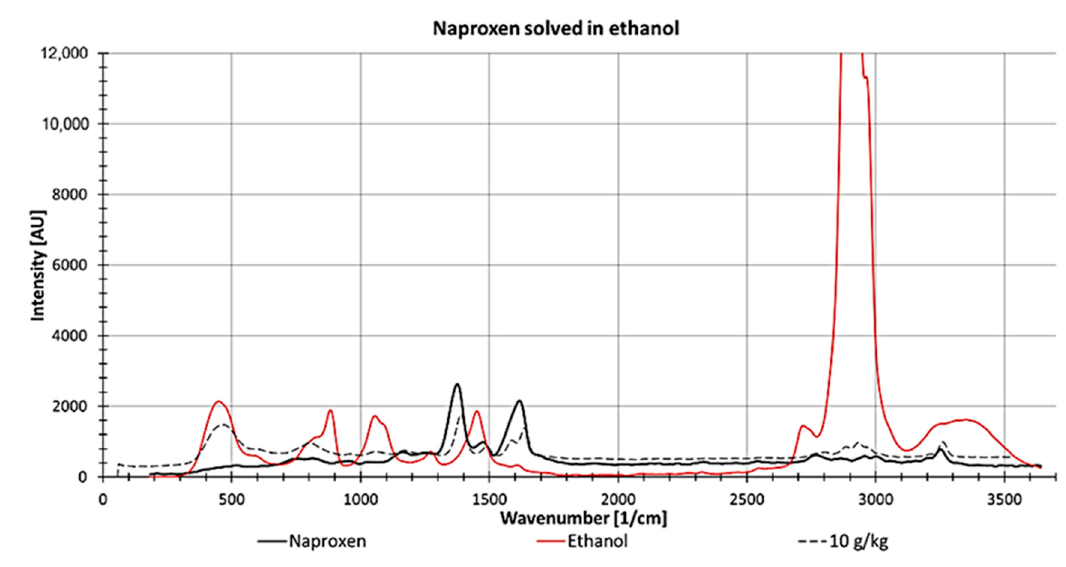
Figure 14. Raman spectrum from naproxen as a solid (black line) and ethanol (measured in a fused silica cuvette, red line) and 10 g naproxen dissolved in 1 kg ethanol (measured in a fused silica cuvette; dotted line).